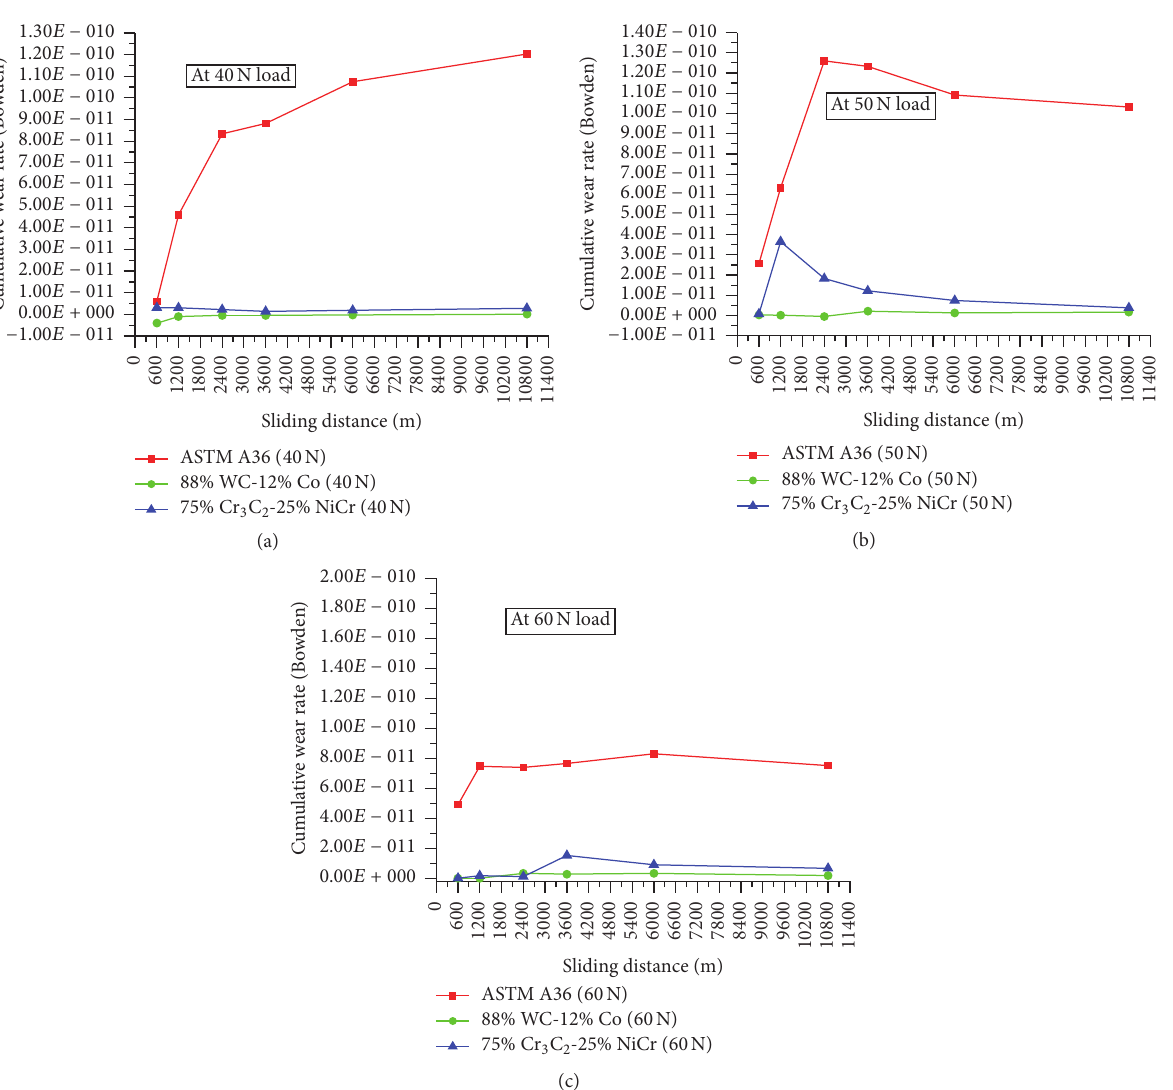
Figure 6: Variation of C.W.R. for uncoated and D-Gun spray coated ASTM A36 steel at normal applied load of (a) 40N; (b) 50 N; (c) 60 N at sliding velocity of 2 ms −1